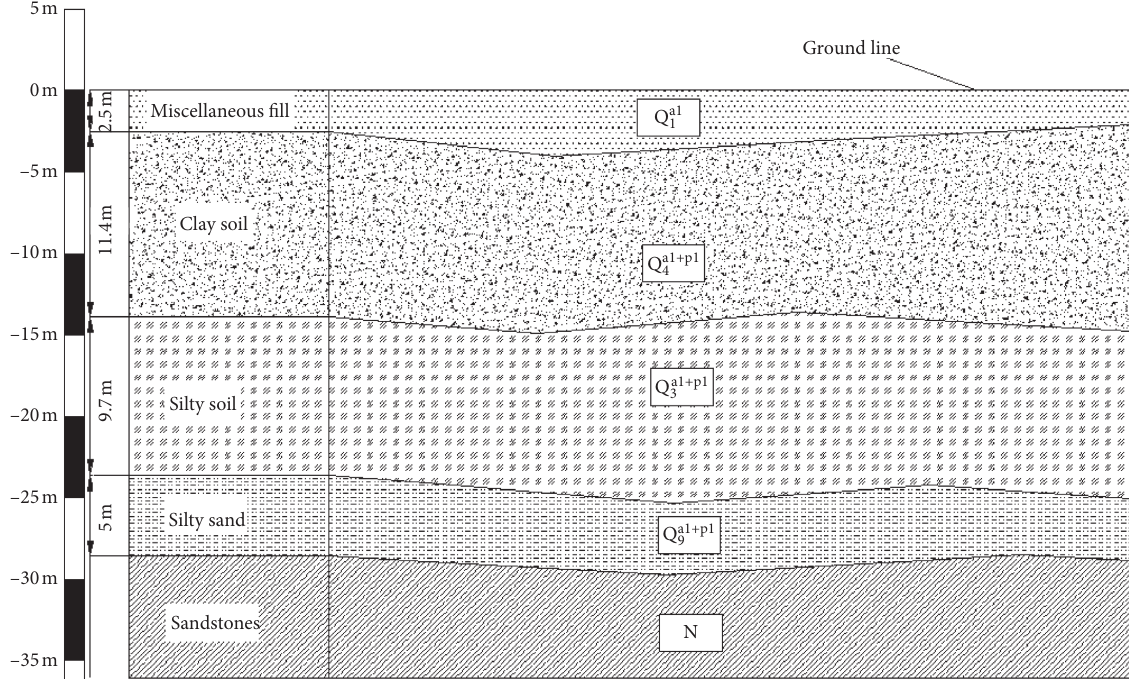
Figure 3: Section map of engineering geology.